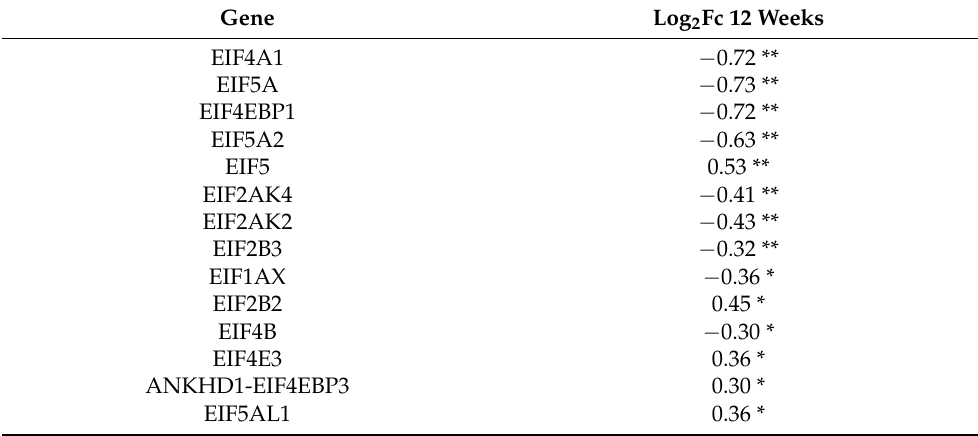
Table 5. eIF-mRNAs exhibiting significant mRNA expression changes after 12 weeks 4OH-tamoxifen adaption [32]. Genes are sorted according to the adjusted p -value. Relative expression (log 2 ) to untreated MCF-7 cells is shown. *, **: adjusted p -value < 0.5 and <0.01, respectively. Gene Log 2 Fc 12 Weeks EIF4A1 − 0.72 ** EIF5A − 0.73 ** EIF4EBP1 − 0.72 ** EIF5A2 − 0.63